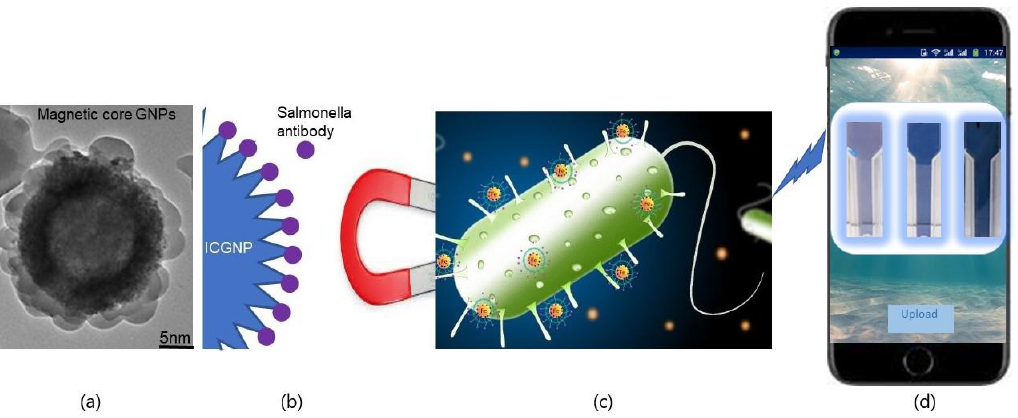
Figure 7. The procedure of monitoring Salmonella by a rapid magnetic fluorescent assay ( a ) TEM image of ICGNP; ( b ) ICGNP-COOH can be conjugated with antibody; ( c ) Magnetic enrichment for Salmonella ; ( d ) Quantification of fluorescent intensity.